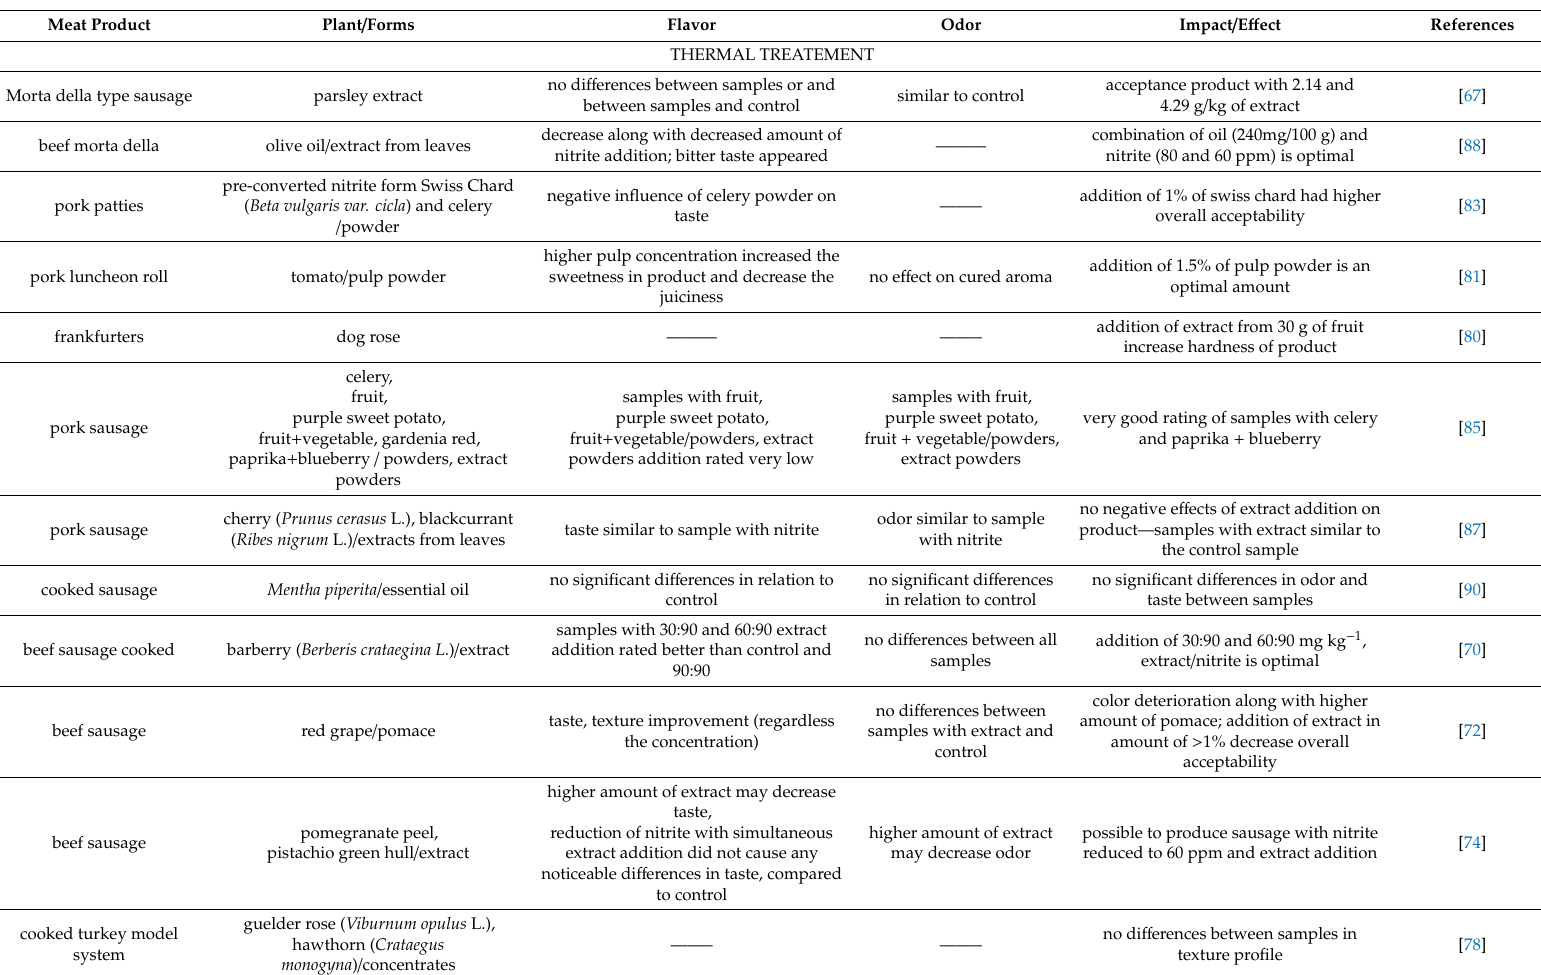
Table 5. Application of plant extracts as natural compounds a ff ecting the taste and smell of meat products with a reduced quantity of